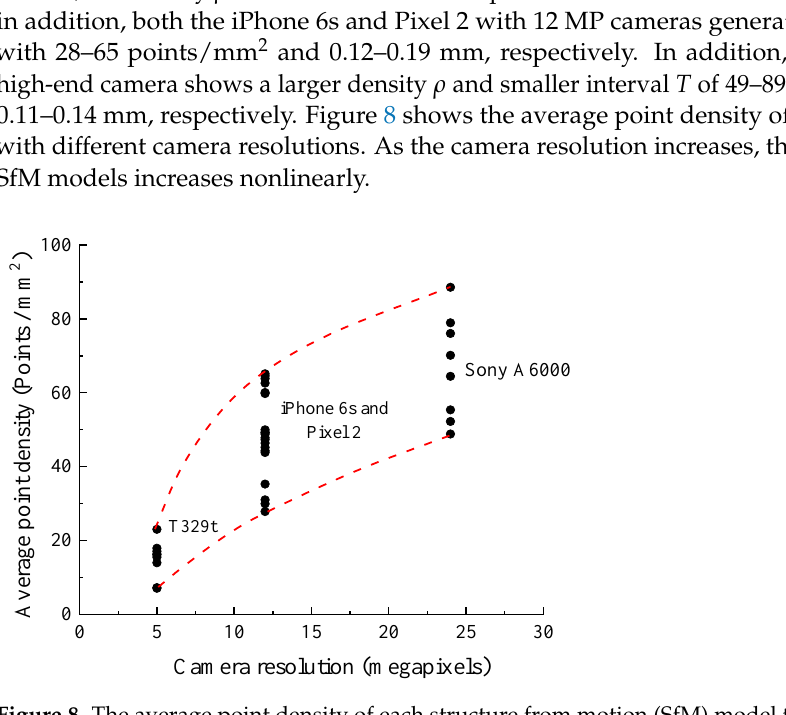
Figure 8. The average point density of each structure from motion (SfM) model that is generated by using the different cameras. using the different